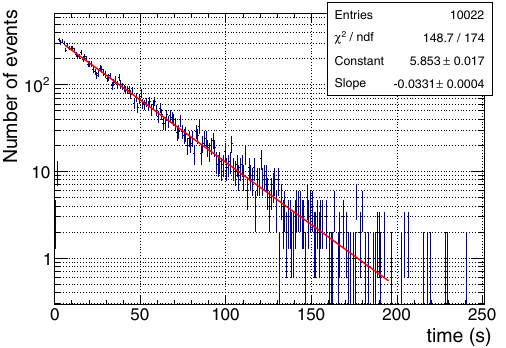
Fig. 4 Distribution of the time intervals between consecutive events occurred during the 90 h-long run n.1232 at (cid:2) T ∼= 6 ◦ C with only back- ground radiation It is apparent that, despite the pronounced variation of the room temperature, the temperature of the water bath remains stablearoundthevalueof24 . 8 ◦ C,withchangesbelow0 . 1 ◦